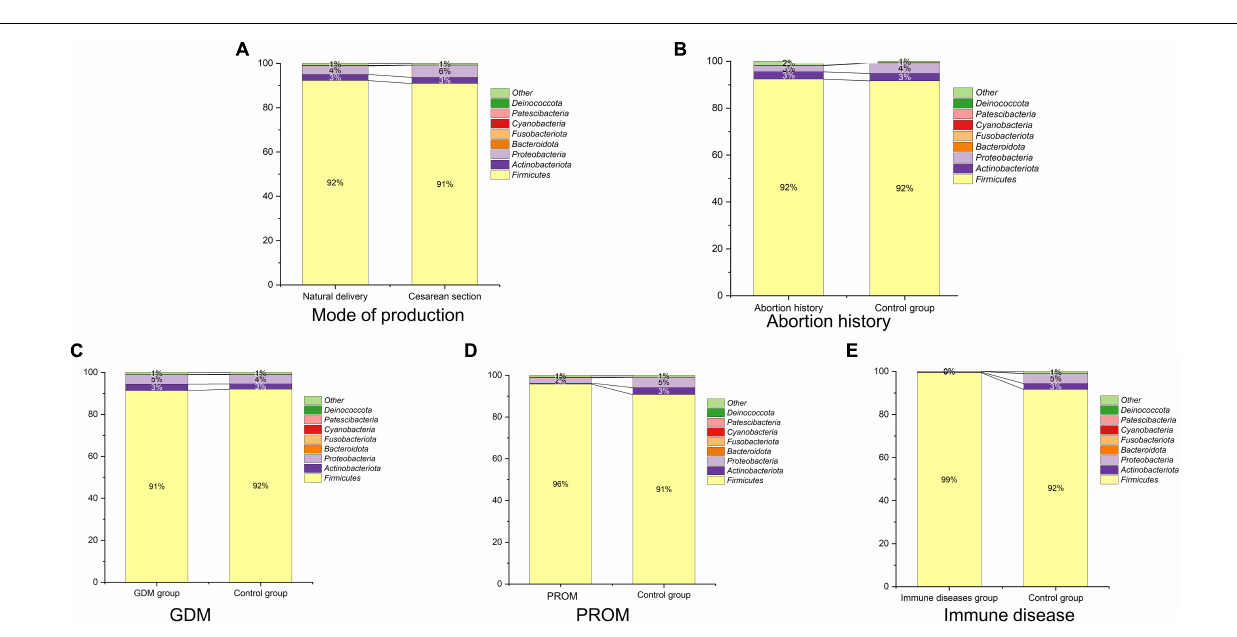
group ( Figure 5A ). Non-ribosomal peptide structures, Kyoto Encyclopedia of Genes and Genomes (KEGG) modules in global maps only were enriched in the GDM